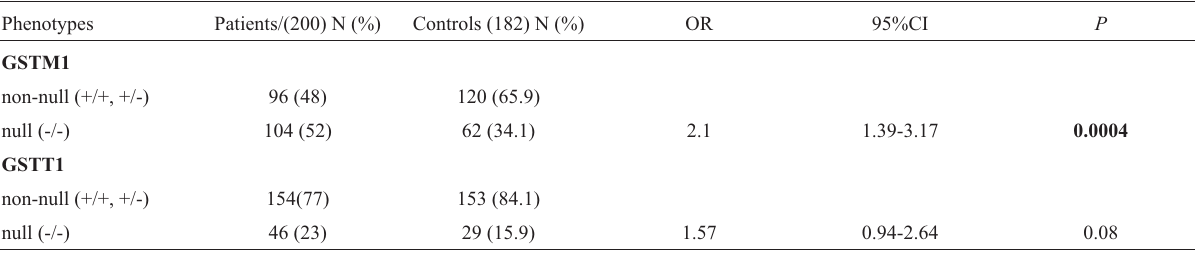
Table 2 - GSTM1 and GSTT1 phenotype frequencies in patient and control groups.